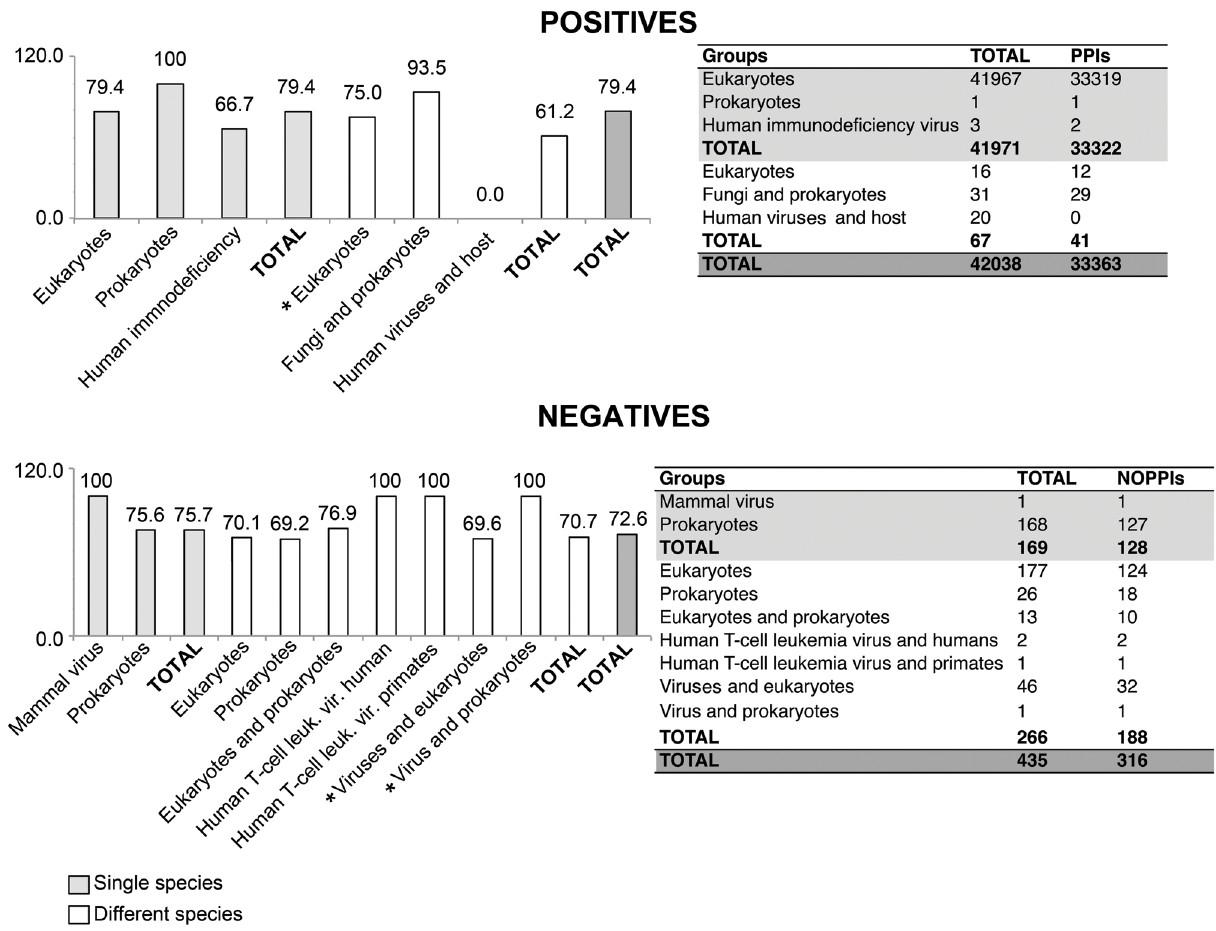
Figure 4. Detailed analysis of the classification of the test set using the F 9 Normal combined model. The values in the right side of each table and the score over each bar indicate the number and percentages of instances correctly classified, respectively. Single species, indicates PPIs and no-PPIs within the same species; Different species, indicates PPIs and no-PPIs among different species; *, groups that include instances of parasite-host associations.